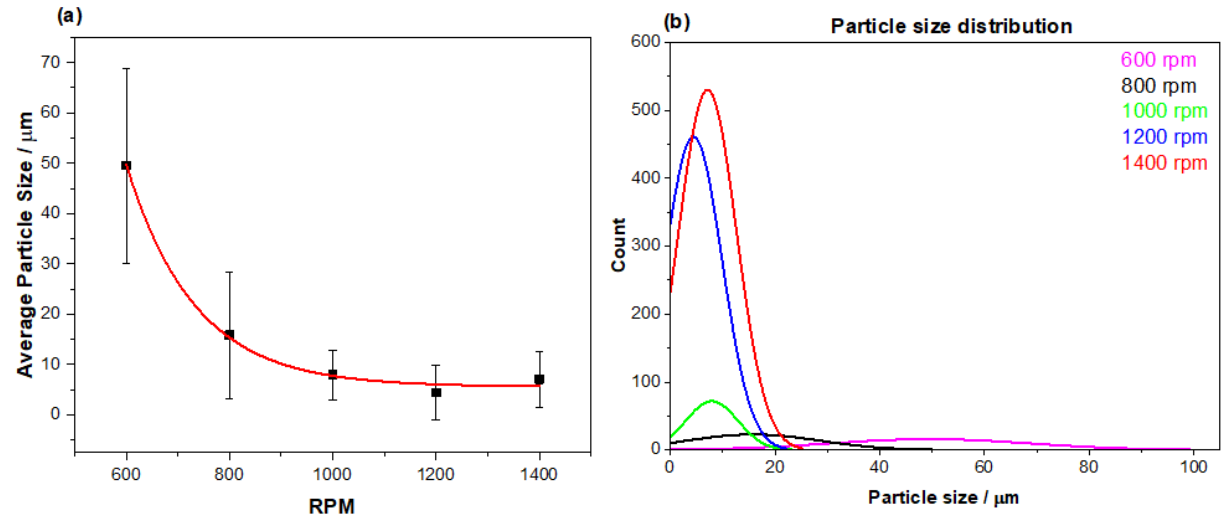
Figure 5. How the stirring speed effects the particle size generated during the emulsion polymerization process with ( a ) relating the average achieved particle sizes with the rpm used (error bars being the ±1 standard deviation in the size measurements), and ( b ) the distribution of the particle sizes at each speed.